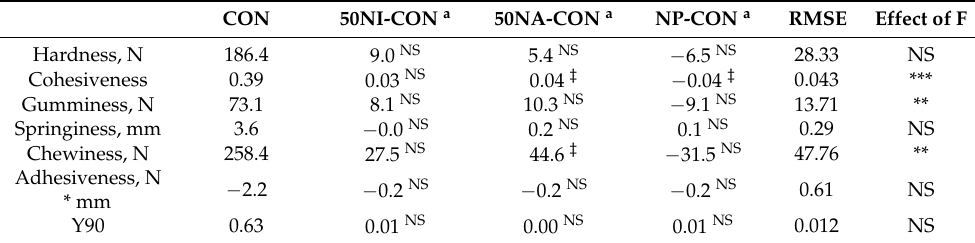
Table 4. Instrumental texture parameters of dry-fermented sausages.